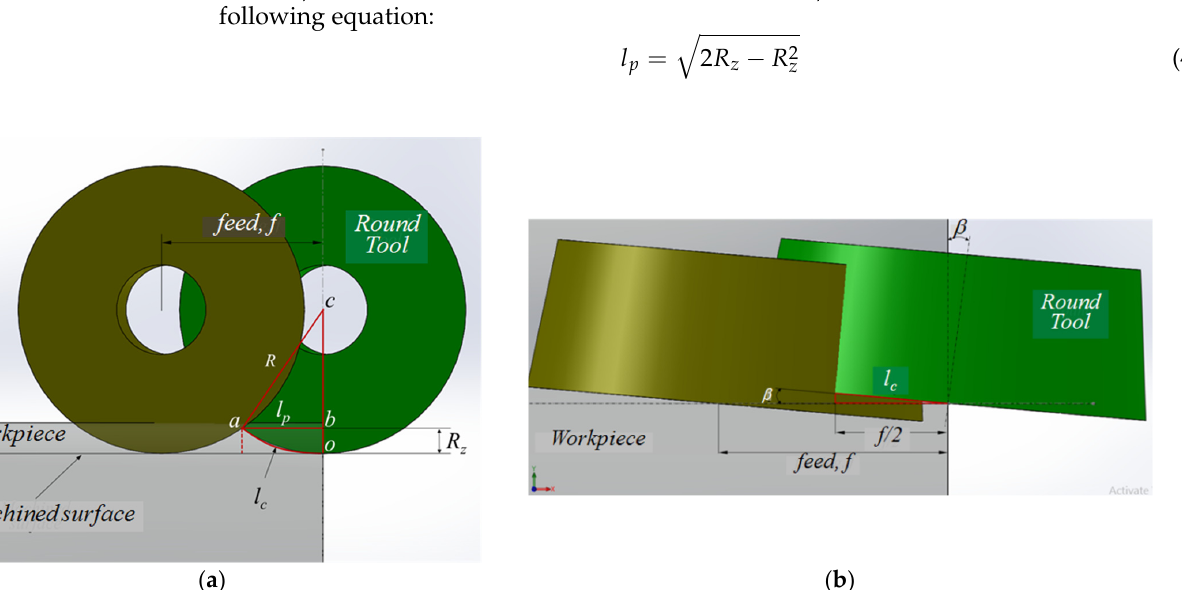
Figure 8. Effects of the tool inclination angle on the average surface roughness ( R a ).